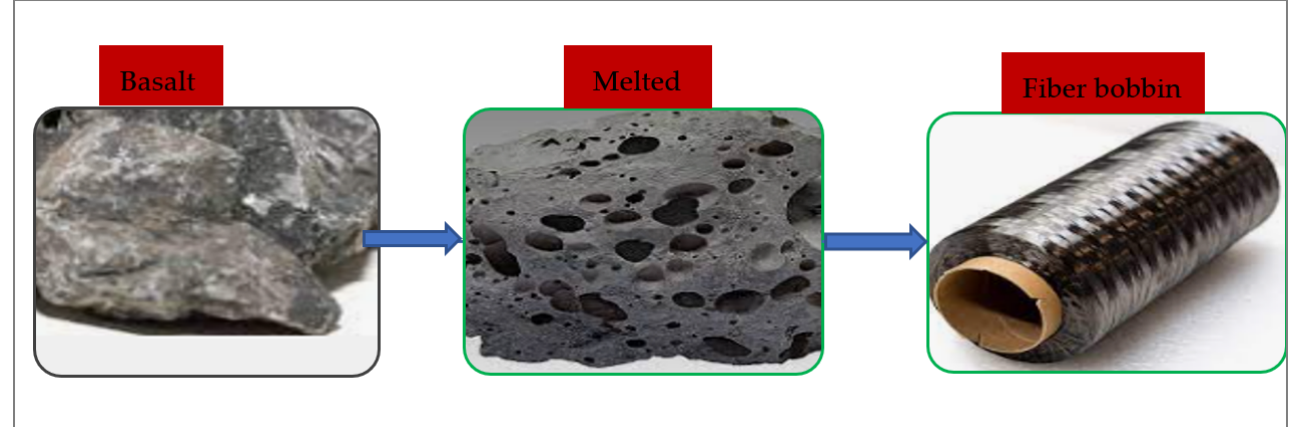
Figure 1. Manufacturing of BFs.